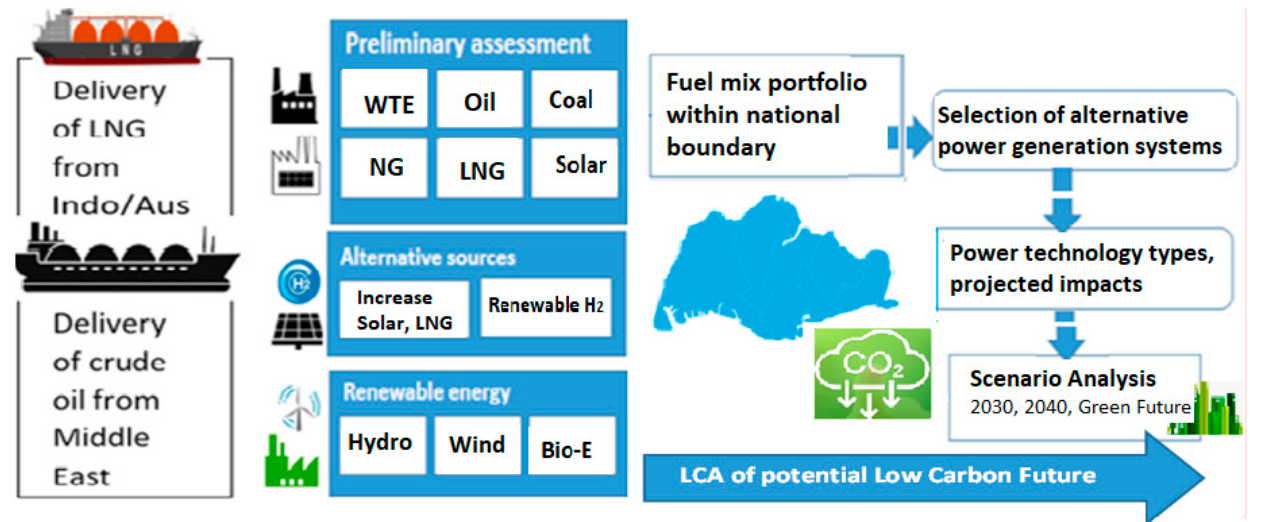
Figure 2. Overall methodology.